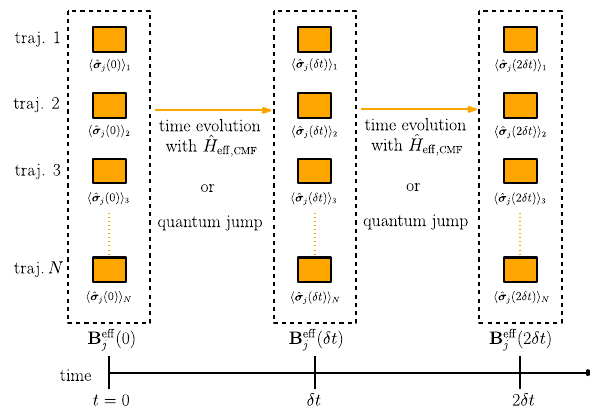
FIG. 3. Quantum trajectories combined with the mean-field or cluster mean-field method. Colored boxes along a given line stand for the time-evolved state of the k th trajectory, which is stochastically chosen among the set of pure states fj ψ 0 ð t Þi k ; j ψ j ð t Þi k g according to Eq. (9). For each of those states, one finds the corresponding mean fields on each site j inside the considered cluster, h ˆ σ j ð t Þi k . The mean field B eff j ð t Þ parametrizing the effective Hamiltonian in Eq. (13), to be used in the master equation for the cluster density matrix, is obtained by averaging over all the N